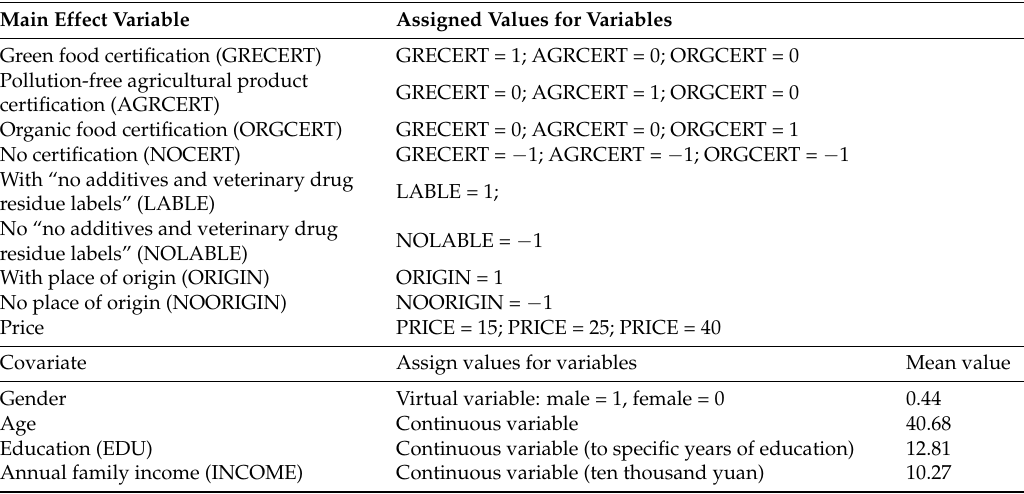
Table 4. The assigned values for the